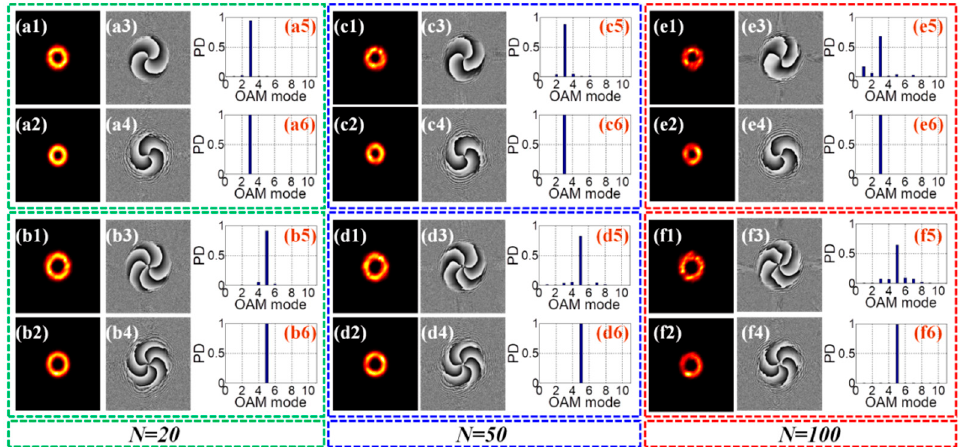
Figure 3. The intensity and phase distributions of orbital angular momentum (OAM) beams and their power density (PD) spectra without and with the pre-compensation of GS algorithm under simulated atmosphericturbulencewithrefractiveindexstructureparameter C 2 n valuedas1 × 10 − 15 m − 2/3 . Theparts circled in green, blue and red dashes’ frames represent simulated turbulence channel with random phase screens number of N = 20, 50 and 100 respectively. (a1, c1, e1) and (b1, d1, f1) are intensity profiles without pre-compensation for topological charge l = 3 and l = 5 respectively, (a3, c3, e3) and (b3, d3, f3) are their corresponding phase distributions, (a5, c5, e5) and (b5, d5, f5) are their corresponding PD spectra. (a2, c2, e2) and (b2, d2, f2) are intensity profiles with the pre-compensation of GS algorithm, (a4, c4, e4) and (b4, d4, f4) are their corresponding phase distributions, (a6, c6, e6) and (b6, d6, f6) are their corresponding PD spectra.